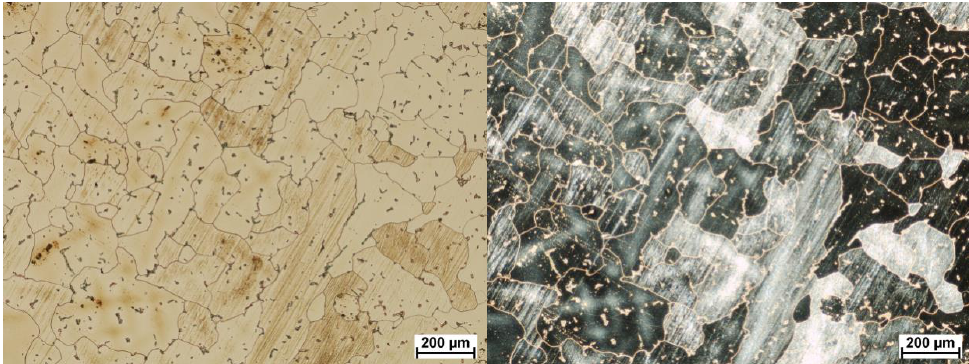
Figure 14. Microstructure area 1, light field on the left, dark field on the right.